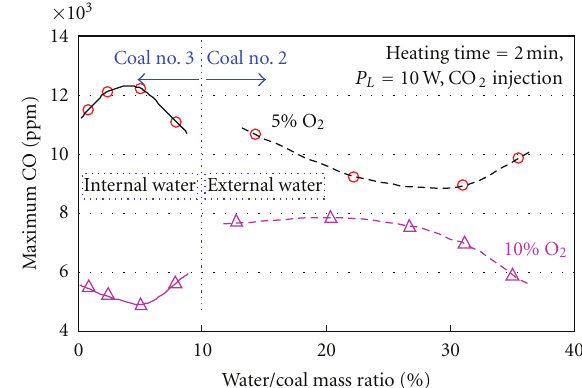
Figure 16: Maximum CO gas concentration versus water/coal mass ratio.